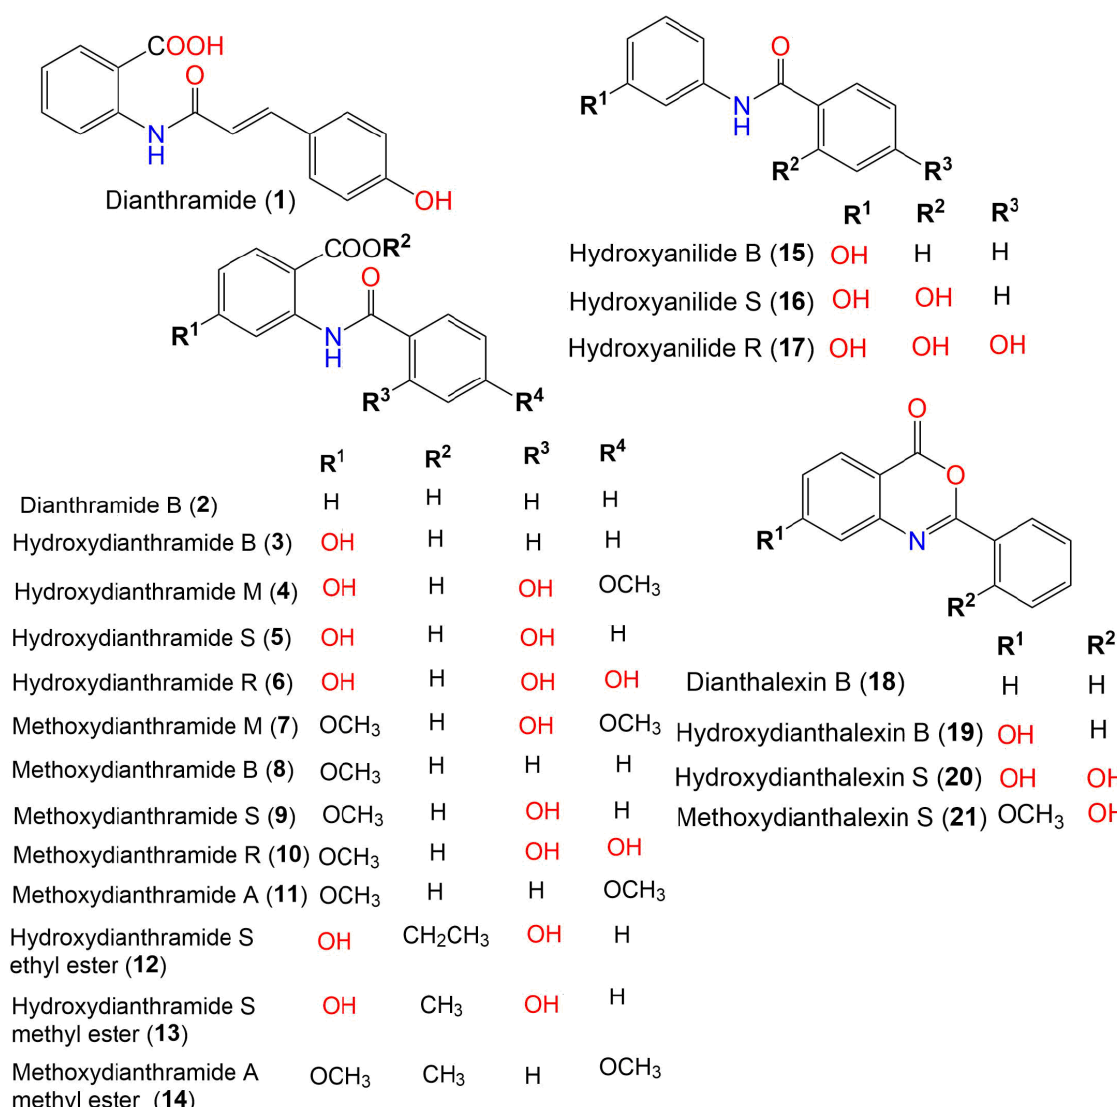
Figure 1. Structures of a nthranilic acid derivatives ( 1 – 21 ) isolated from F. oxysporum